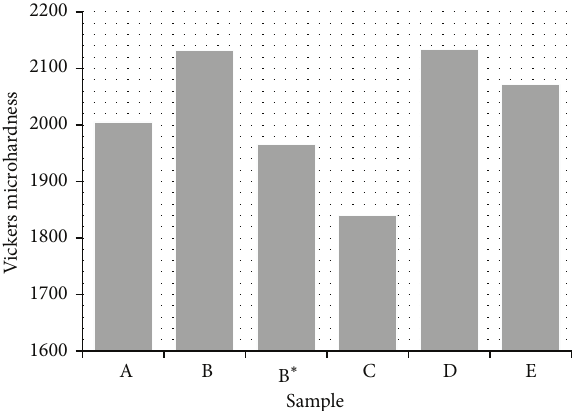
Figure 8: Values of Vickers microhardness (B ∗ is related to sample B free of